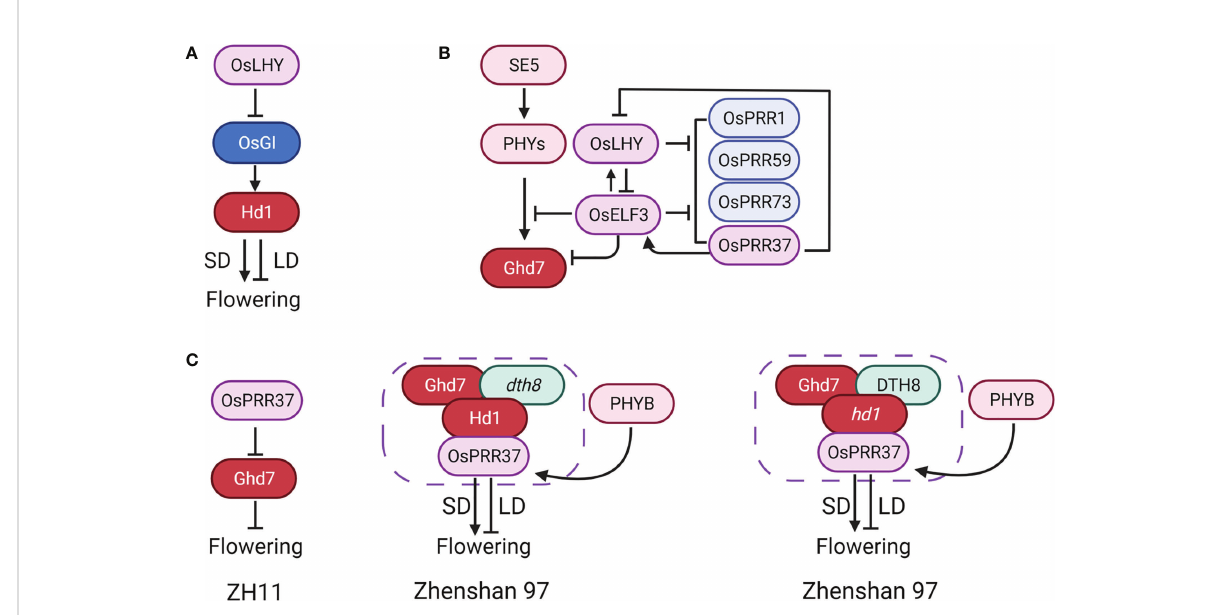
FIGURE 5 Circadian clock pathway is critical to the reversal mechanism. (A) The OsLHY - OsGI - Hd1 pathway could fi ne-tune the CDL by adjusting the degree of coincidence between Hd1 expression and day length. (B) The possible fl owering mechanism of OsELF3 . OsELF3 suppresses the phytochrome signal, prevents light from entering Ghd7 and impresses Ghd7 expression. (C) OsPRR37 acts as an activator or a suppressor depending on the background, and three genes, Hd1 , Ghd7 , and DTH8 . Arrows represent positive regulation, inhibitors represent negative regulation, and graphical overlap represents protein physical